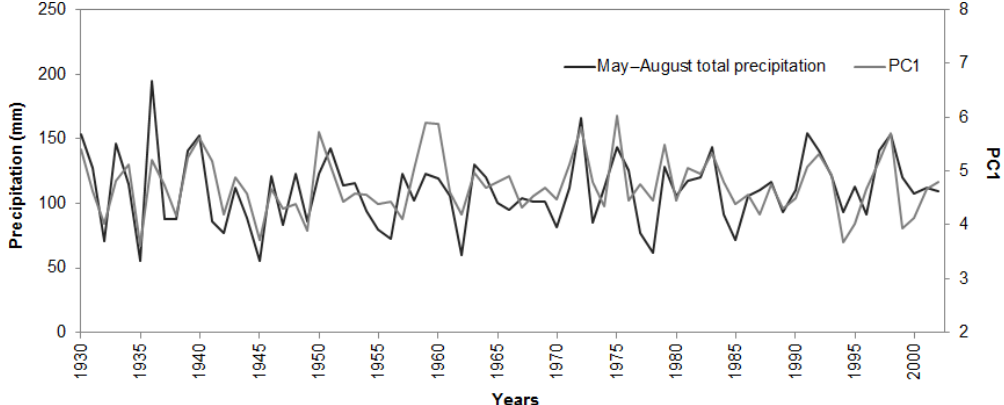
Figure 3. The comparison of May–August total precipitation (black) and the first principal component of 23 tree-ring chronologies (gray). Correlation coefficient between two time series is 0.65 ( p